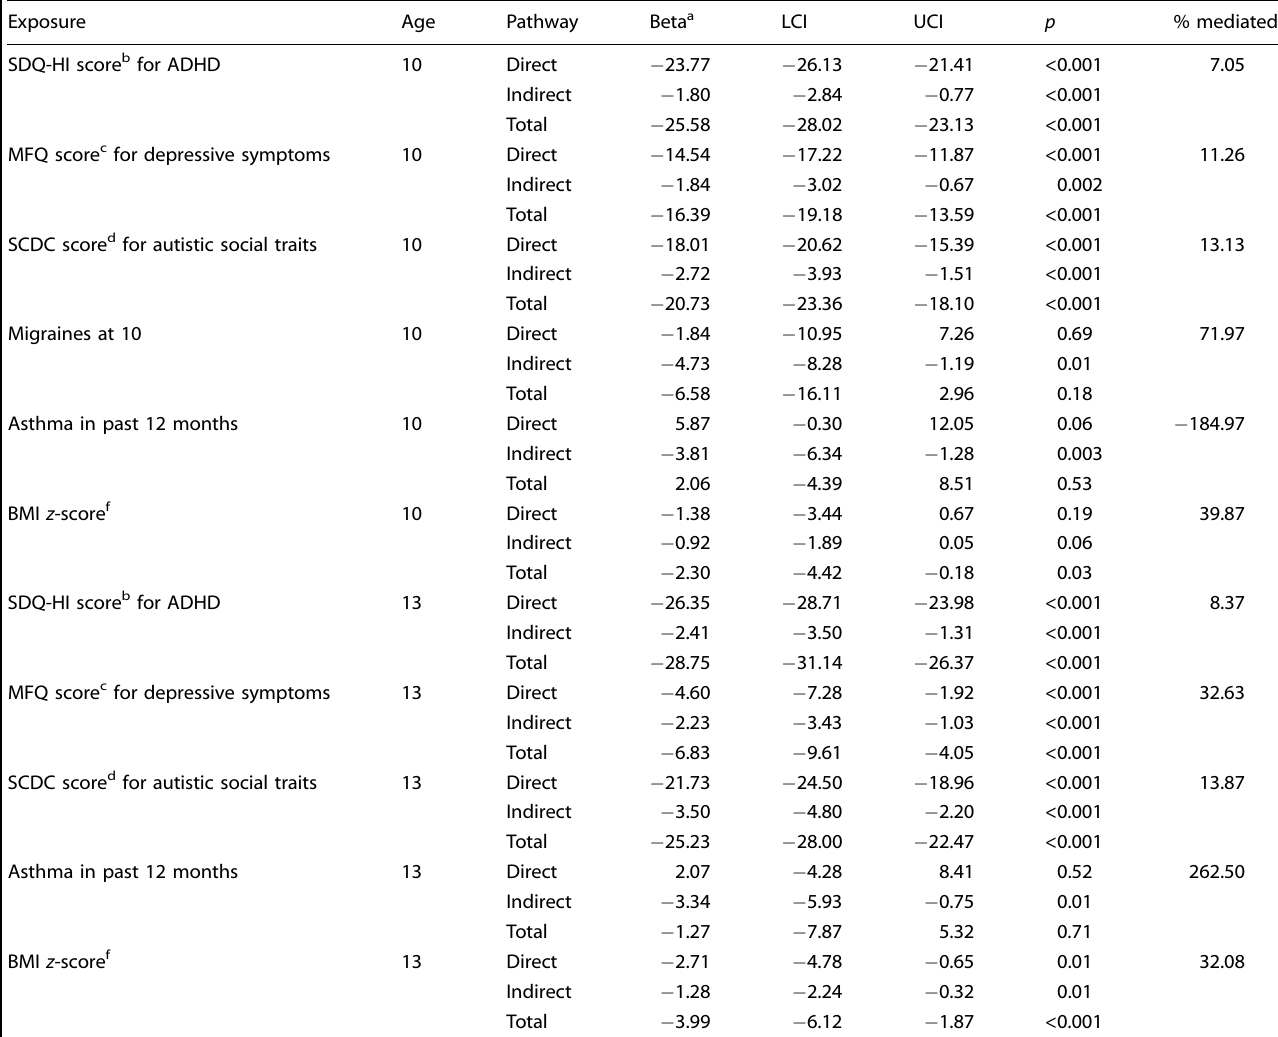
Table 3. Mediation by absenteeism at age 14 – 16 of associations of health conditions with educational attainment at 16. Exposure Age Pathway Beta a LCI UCI p SDQ-HI score b for ADHD 10 Direct